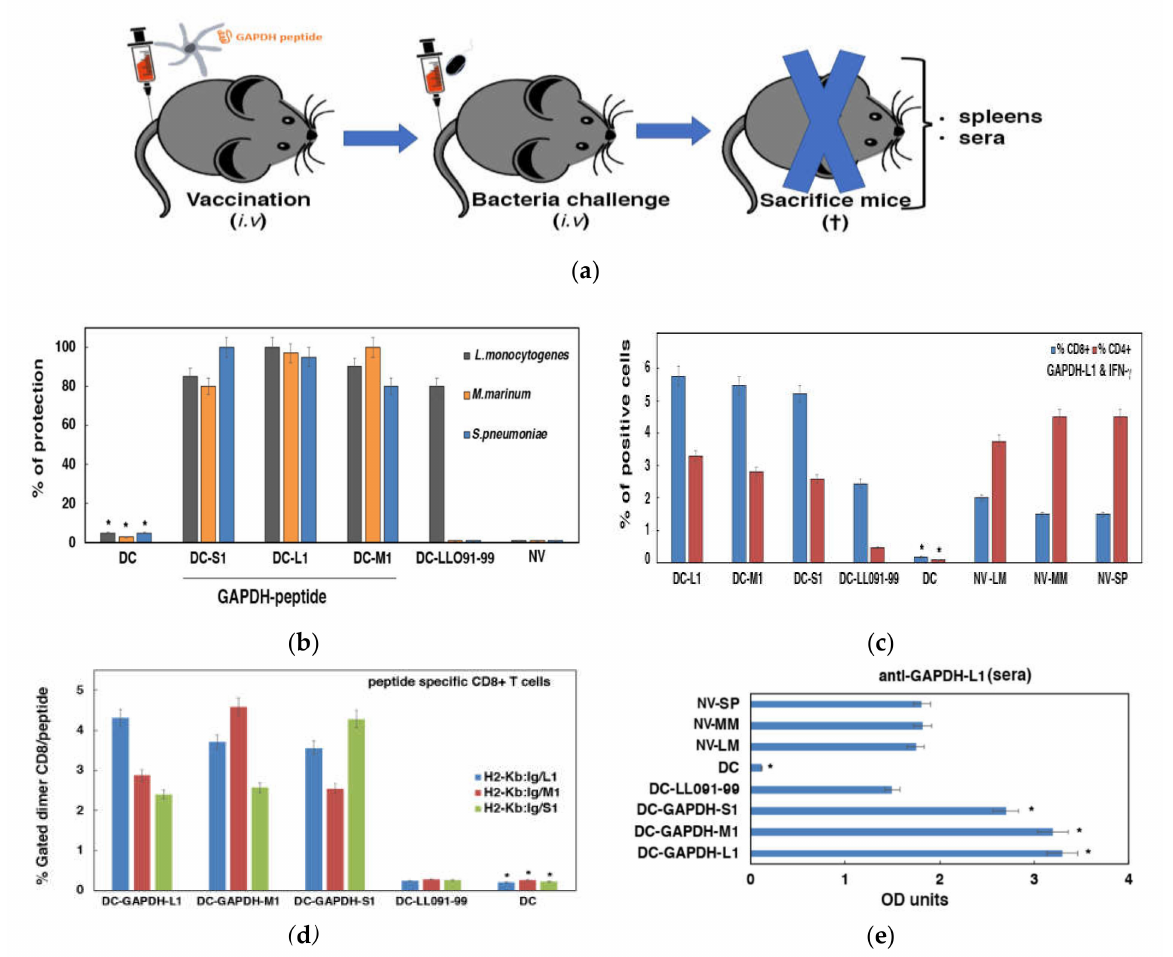
Figure 3. Validation of DC loaded with GAPDH peptides as cross-reactive vaccines for LM, MM or SP infections. ( a ) Vac- cination protocol of C57BL/6 mice with a single dose of DC vaccines. Seven days later, each group of vaccinated mice were divided into 3 sets and challenged i.v. with 10 4 CFU/mice of hypervirulent strains of LM, MM or SP. Next, after 14 days mice were bled, sacrificed and spleens collected. ( b ) Vaccination results expressed percentages of protection as the mean ± SD of triplicates. Percentages are calculated as the number of CFU/mL counted in spleen homogenates of NV mice (saline) divided by CFU/mL of each set of vaccinated mice. Results are expressed as the mean ± SD of triplicates. Student t -test was applied for statistics. * p < 0.05 compared to DC samples. ( c ) Intracellular cytokines of CD4 and CD8 positive cells specific for GAPDH-L1. Spleen homogenates of DC vaccinated mice or NV were analyzed by flow cytometry and the percentages of CD8 + or CD4 + T cells are shown. Percentages of CD4 + (red) and CD8 + (blue) positive cells are expressed as the mean ± SD of triplicates. ANOVA test was applied. * p < 0.05 compared to DC samples. ( d ) Frequencies of GAPDH-L1, GAPDH-M1 or GAPDH-S1-specific CD8 + T cells induced by DC vaccines are shown. Splenocytes of vaccinated or NV mice were incubated with recombinant dimeric H-2Kb: Ig fusion protein loaded with each peptide. The staining cocktail contained dimeric fusion protein loaded with peptides, CD8 and IFN- γ antibodies. CD8 + were gated for anti-IFN- γ staining (%gated dimer-CD8) to calculate the frequencies of CD8 + -peptide restricted cells and IFN- γ producers. Results are the mean ± SD of triplicates. ANOVA test was applied. * p < 0.05 compared to DC samples. ( e ) Sera from vaccinated or NV mice were thawed to check a peptide-ELISA. Reactions were developed with goat anti-mouse IgG and absorbances (OD) analyzed at 450 nm. Results are expressed as the mean ± SD of triplicates. Student t -test was applied for statistics. * p < 0.05 compared to DC